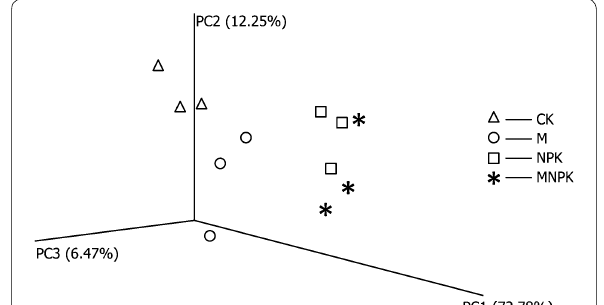
Fig. 2 PCoA of the pyrosequencing reads based on the weighted Fast UniFrac metric. The first three axes are drawn and the percent of variance explained by each axis is given. Treatment: (triangle) CK, no fertilizer; (circle) M, manure; (square) NPK, inorganic phosphorus, potassium and nitrogen fertilizer; (star) MNPK, inorganic P, K and N fertilizer plus